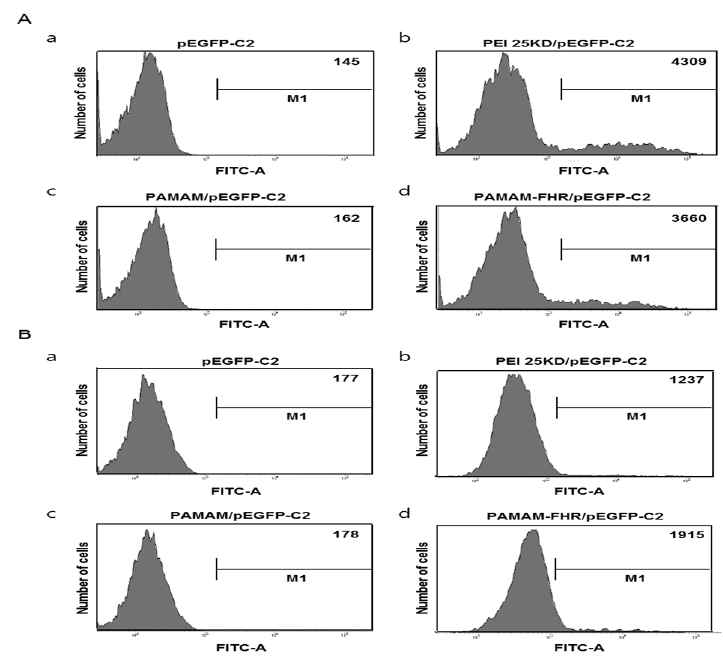
Figure 4. The expression of GFP by the PAMAM-FHR. ( A ) GBL-14 and ( B ) dermal fibroblasts were incubated for 24 h with each polymer/GFP DNA complexes. GFP expression was assessed by FACS analysis.